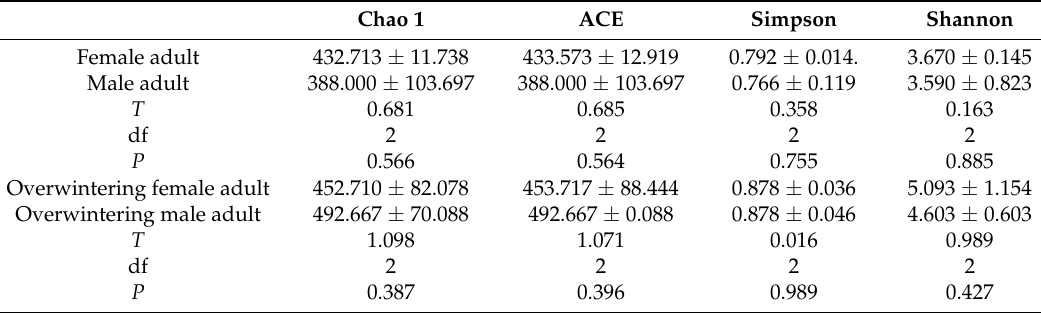
Figure 9. Venn diagram representing the distribution of the fungal OTUs in different sexes of. ( a ) Adult females vs. adult males; ( b ) overwintering adult females vs. overwintering adult males. Table 4. Biodiversity index values of T. klimeschi in different